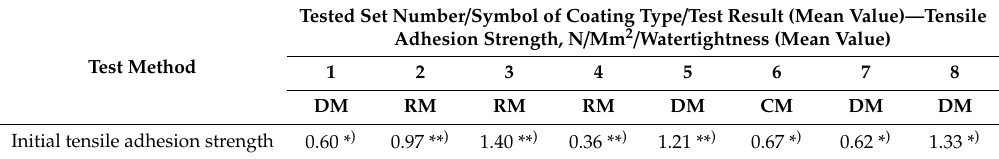
Table 2. Results of initial adhesive strength for eight coating